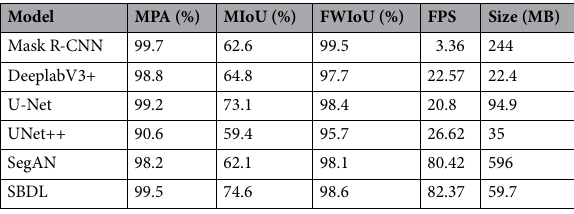
Table 1. Segmentation results of different models.